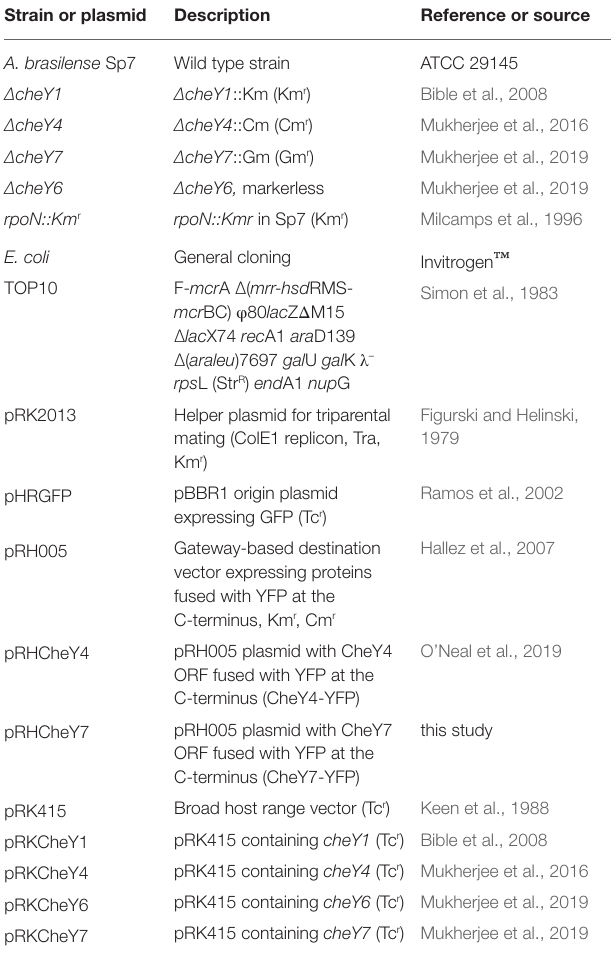
TABLE 1 | The list of strains and plasmid used in this